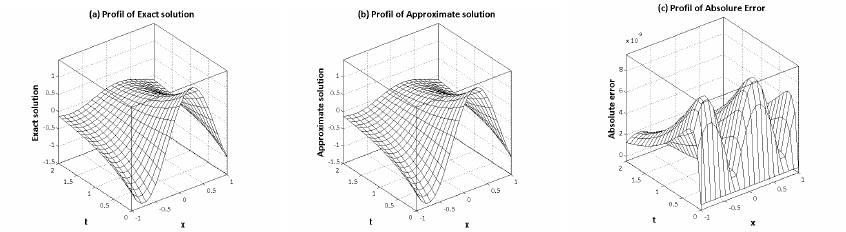
Figure 1. Computational results of Example (1) for N = 16 and ∆t = 10 − 3 .